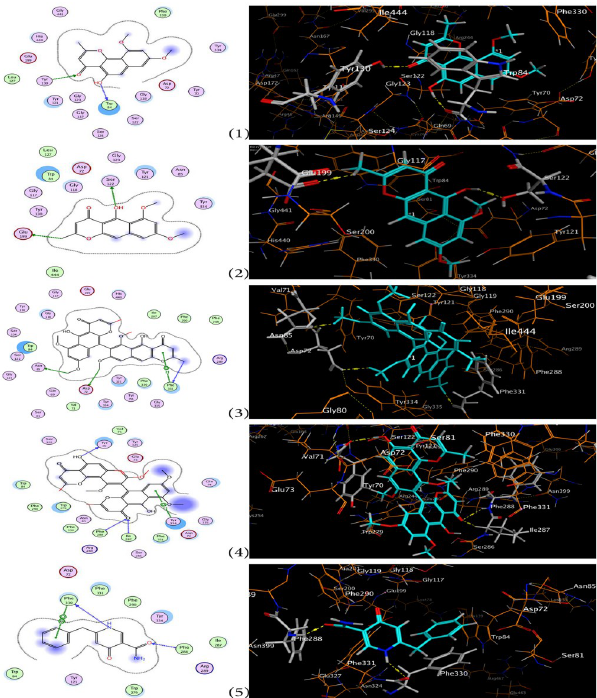
Fig 6. Binding residues of (1) flavasperone, (2) rubrofusarin B, (3) aurasperone A, (4) fonsecinone A and (5) aspernigrin A in AChE assay using MOE program. Dashed yellow lines indicate H-bonds in 3D ligand interaction diagram and blue ones in 2D diagram. Carbons are in turquoise, nitrogens in blue, and oxygens in red.